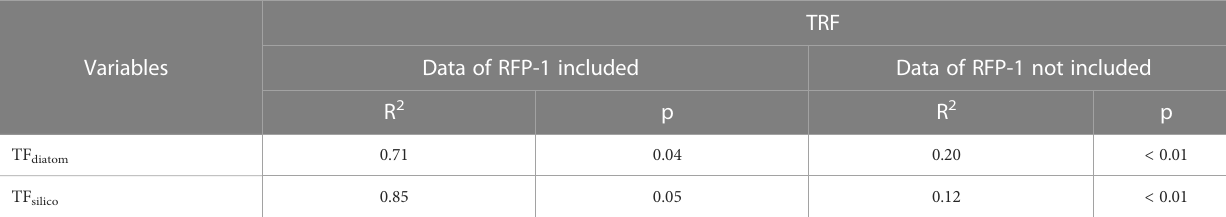
TABLE 5 Correlations between TRF and TF diatom , and TRF and TF silico in the trap in Prydz Bay polynya.